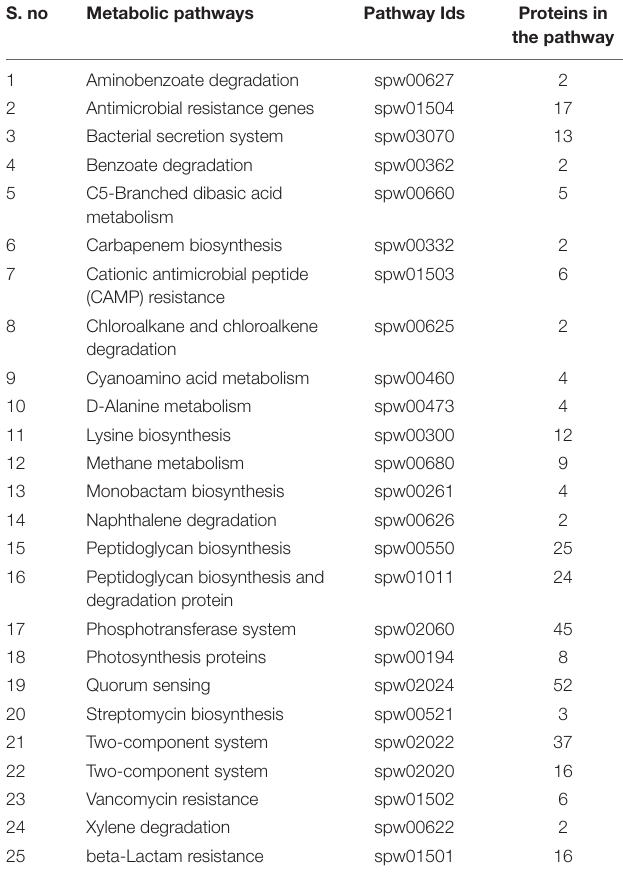
TABLE 2 | Unique metabolic pathways: List of all unique metabolic pathways and uniquely present proteins in these metabolic pathways present in S. pneumoniae . S.